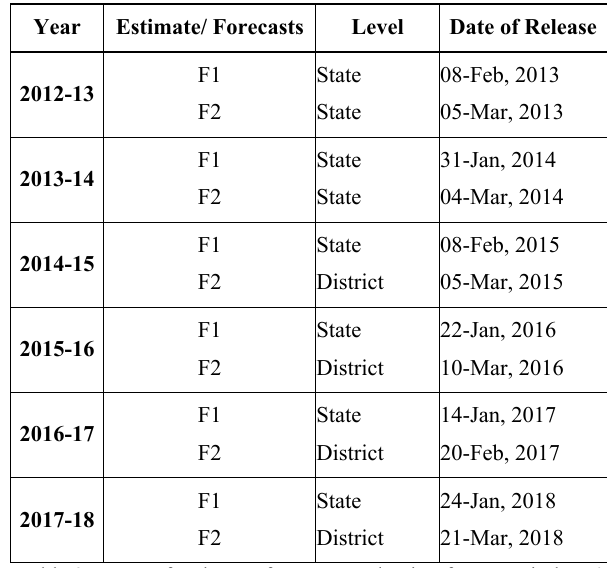
Table 2. Dates of Release of Potato Production forecasts in last 6 years